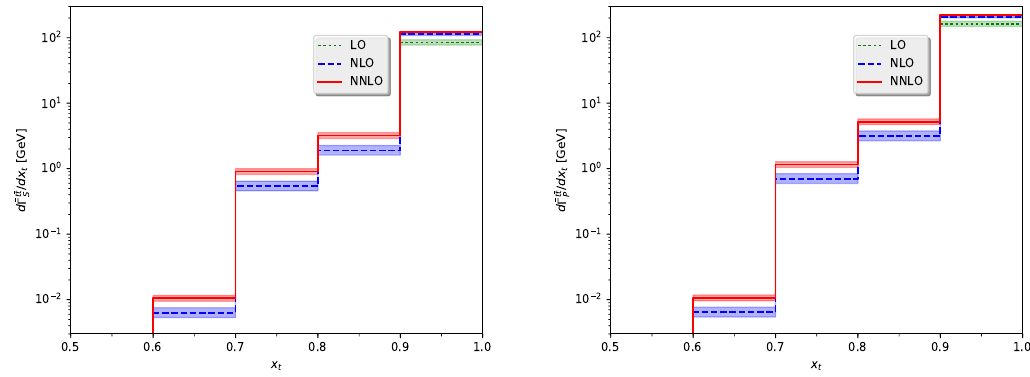
(cid:22) t Figure 3 . Left plot: distribution d (cid:0) t =dx t of the normalized top-quark energy x t = 2 E t =m h for S a 500 GeV scalar Higgs boson with a t = 1 at LO (short-dashed, green), NLO (long-dashed, blue), and NNLO (solid, red) QCD. The short-dashed, long-dashed, and solid lines correspond to the scale choice (cid:22) = m h while the shaded bands show the e(cid:11)ect of varying the renormalization scale between m h = 2 and 2 m h . Right plot: same as left plot, but for a pseudoscalar Higgs boson with b t = 1. t (cid:22) t;HS X = S; P . For m (cid:22) = m h = 500 GeV and h we get (cid:0) 2